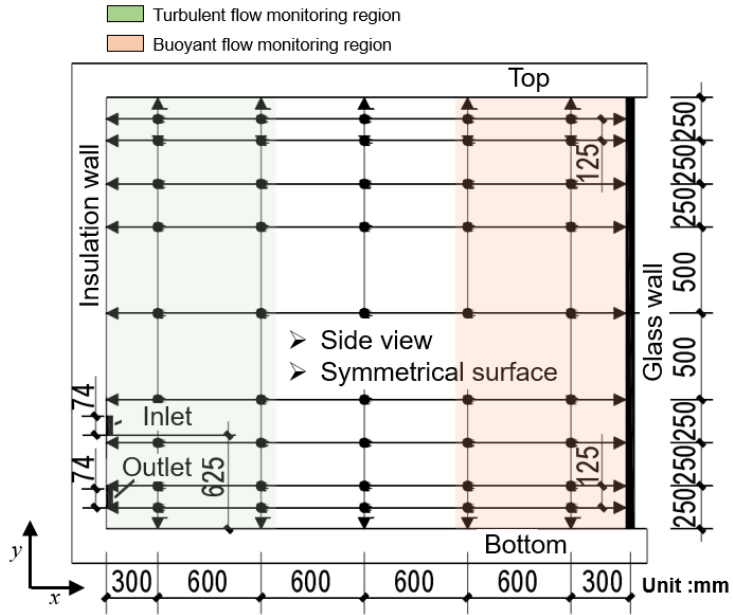
and the corresponding wall temperature in Case 2 and Case 3 varied similarly from bottom to top, Figure 12. Arrangement of points for monitoring indoor space radiation. indicating that the radiation temperature distribution in the space is Under the same operating conditions, the glass wall surface temperature was consid- erably higher than the indoor radiation temperature, and the difference between the two temperatures determined the flow of radiation. As displayed in Figure 13, the difference between the glass wall surface temperature and the radiation temperature in Case 1 was